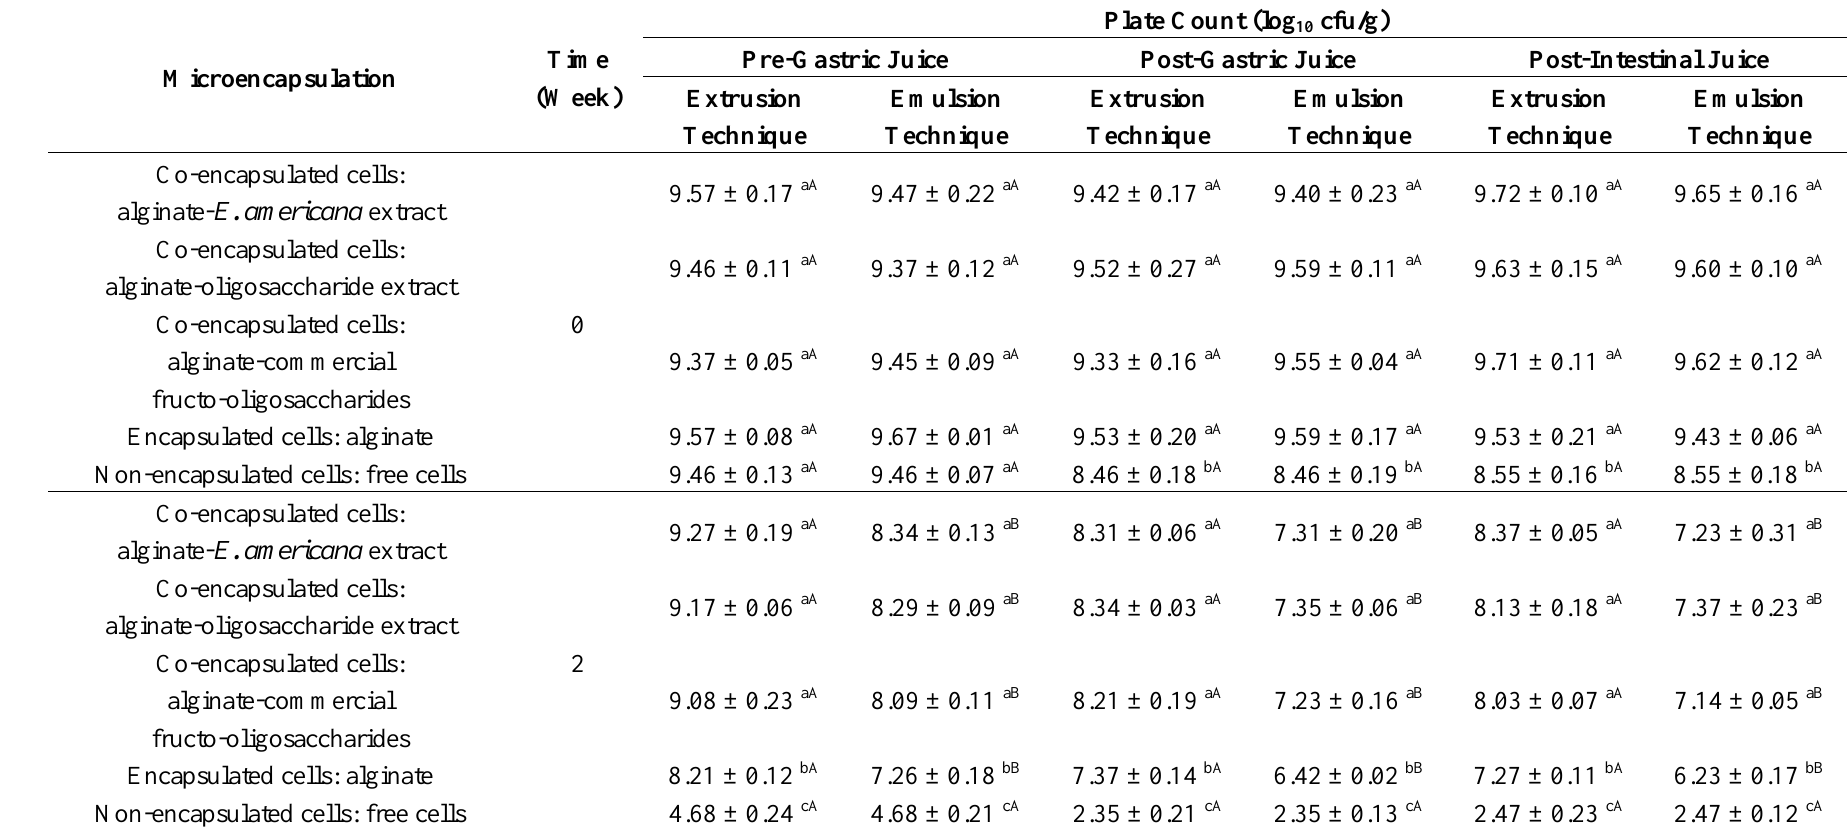
Table 3. Survival of microencapsulated Bifidobacterium longum with Eleutherine americana after sequential incubation in simulated human gastric and intestinal juices.